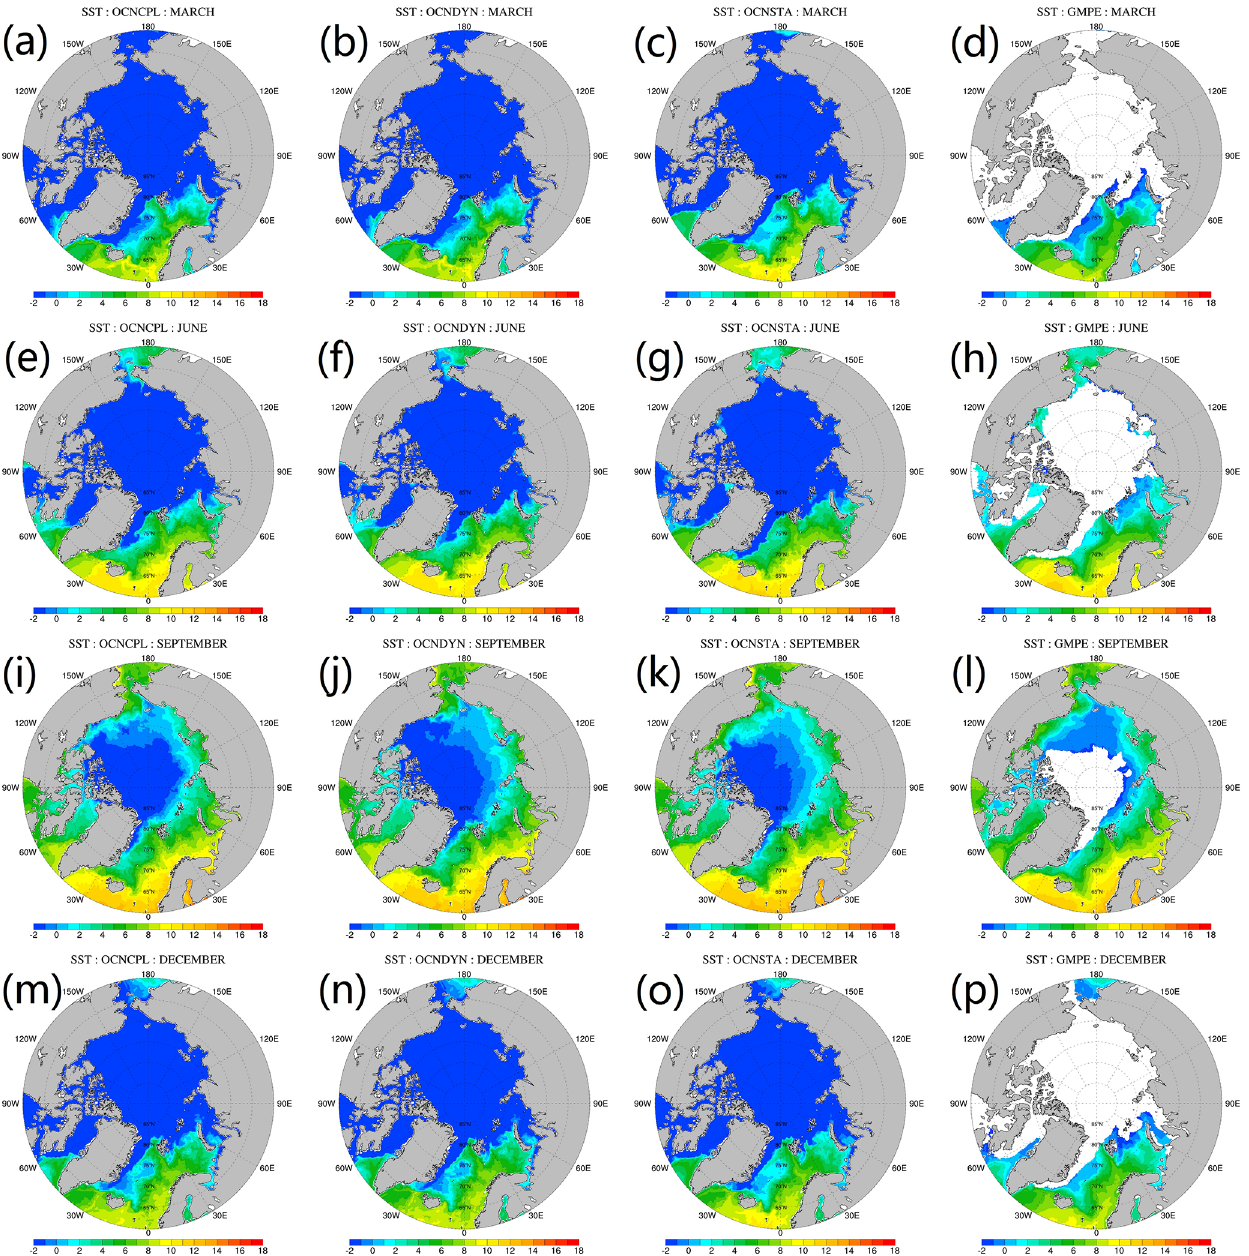
Figure 14. Modeled and observed monthly mean SST. From top to bottom panels show the March, June, September and December SST, respectively. From left to right panels show the SST of the OCNCPL run, the OCNDYN run, the OCNSTA run and the GMPE observations, respectively. GMPE: Group for High-Resolution Sea Surface Temperature Multi-Product